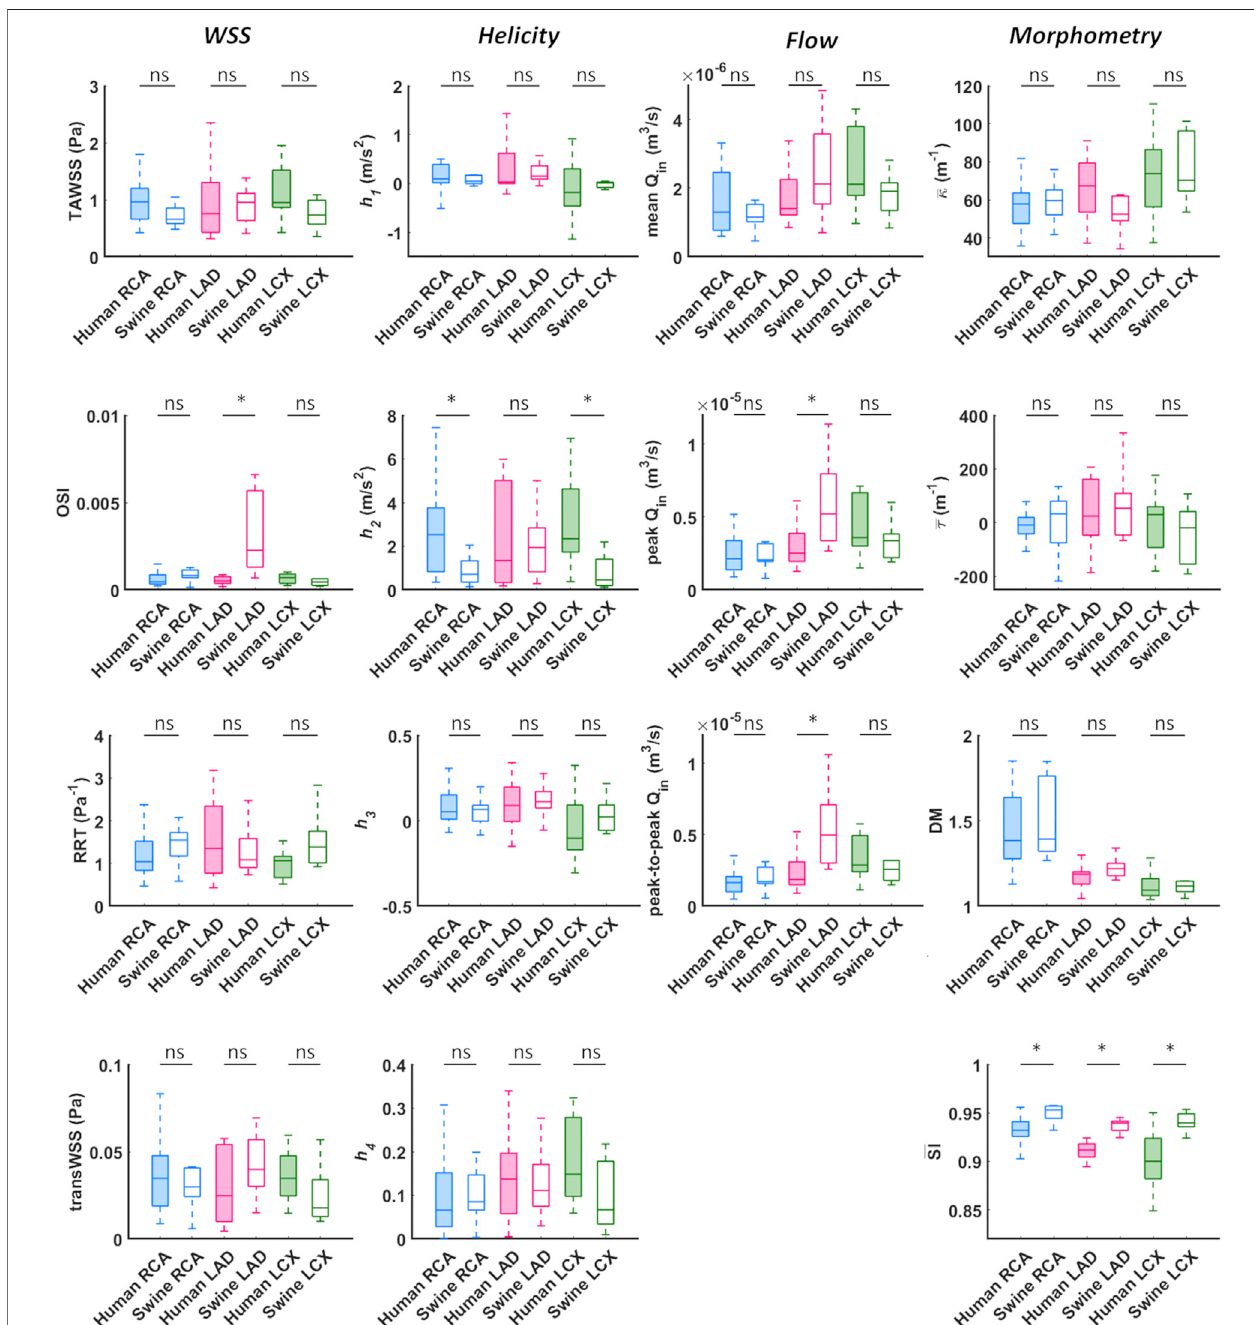
FIGURE 9 | Box plots comparing WSS, helicity, fl ow rate, and morphometry in human and swine coronary arteries. For each population, right (RCA), left anterior descending (LAD), and left circum fl ex (LCX) coronary artery geometries are grouped and distinguished by box color (blue, magenta, and green, respectively). WSS column:TAWSS-time-averagewallshearstress,OSI-oscillatoryshearindex,RRT-relativeresidencetime,transWSS-transversewallshearstress; Helicity column: h 1 - average helicity, h 2 - average helicity intensity, h 3 -signed balanceof counter rotating helical fl ow structures, h 4 - unsigned balanceof counter rotating helical fl ow structures; Flow column: Q in - in fl ow rate; Morphometry column: κ - curvature, τ - torsion, DM - distance metric, SI - similarity index. Median and interquartile range are displayed for each descriptor. * p < 0.05.